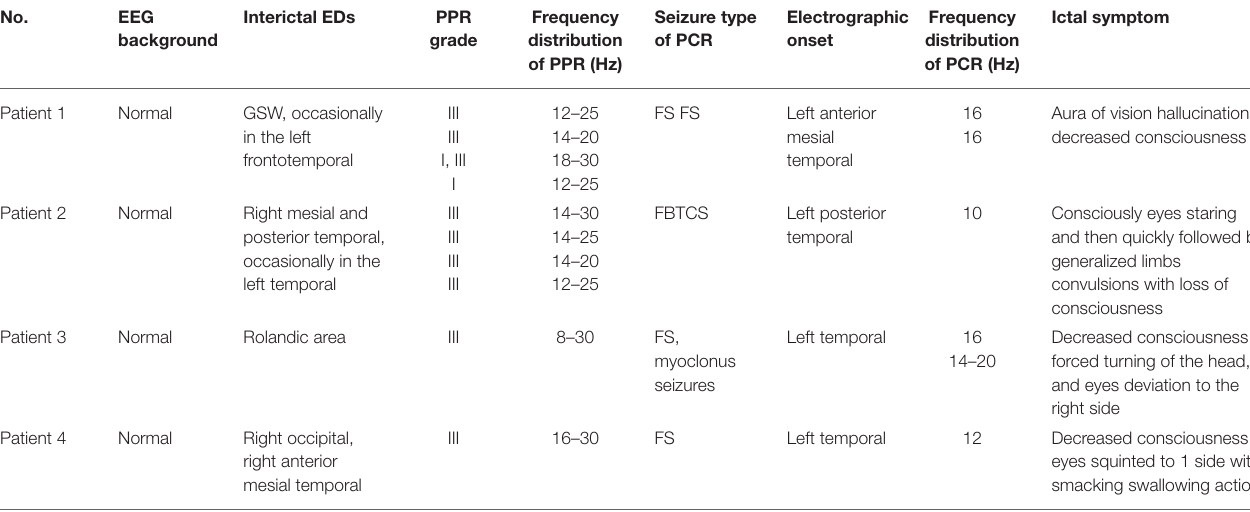
TABLE 2 | Summary of EEG findings of individuals with temporal onset focal seizure induced by IPS. No.